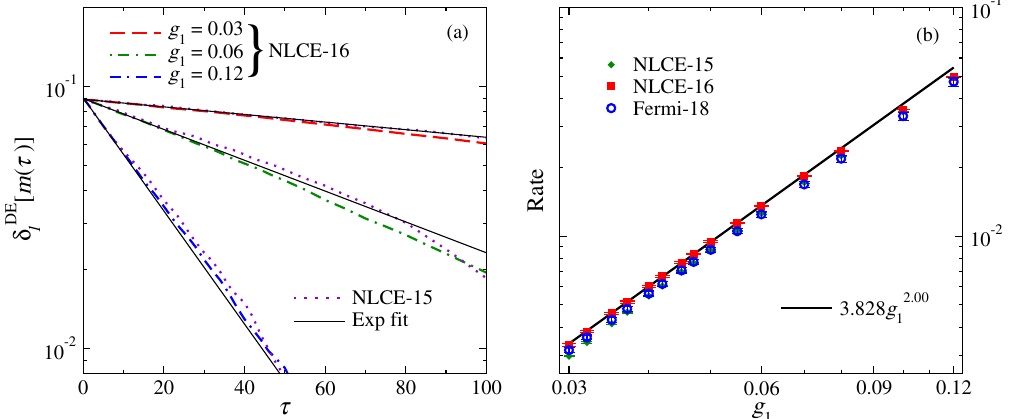
τ Þ [Eq. (50)] after quenches ˆ H → ˆ H “ distance ” to FIG. 6. Dynamics of the momentum distribution function m 1 . (a) Dynamics of the k ð I equilibrium δ DE ½ m ð τ Þ(cid:2) ; see Eq. (57). NLCE results are shown for l ¼ 16 [NLCE-16] and l ¼ 15 (NLCE-15, dotted lines). Straight lines in (a) depict fits to the results for l ¼ 16 in the interval τ ∈ ½ 2 ; 6 (cid:2) and to exponential functions ∝ exp ½ − Γ NLCE 16 ð g 1 Þ τ (cid:2) . (b) Thermalization τ Þ (filled symbols) obtained from fits as the ones in (a), for l ¼ 16 in the interval τ ∈ ½ 2 ; 6 (cid:2) (NLCE-16), and for rates Γ NLCE ð g 1 Þ of m k ð l ¼ 15 in the interval τ ∈ ½ 2 ; 5 (cid:2) (NLCE-16), reported for g 1 ∈ ½ 0 . 03 ; 0 . 12 (cid:2) . Error bars show 95% confidence bounds for the fits. The straight line is the result of a fit to Γ NLCE 16 Fig. 1(c)] obtained by evaluating Fermi ’ s golden rule [see Eqs. (53) and (54)] using full exact diagonalization in chains with L ¼ 18 (Fermi-18) and periodic boundary conditions. The error bars show the standard deviation from averages over different choices of Δ E and τ (see Appendix